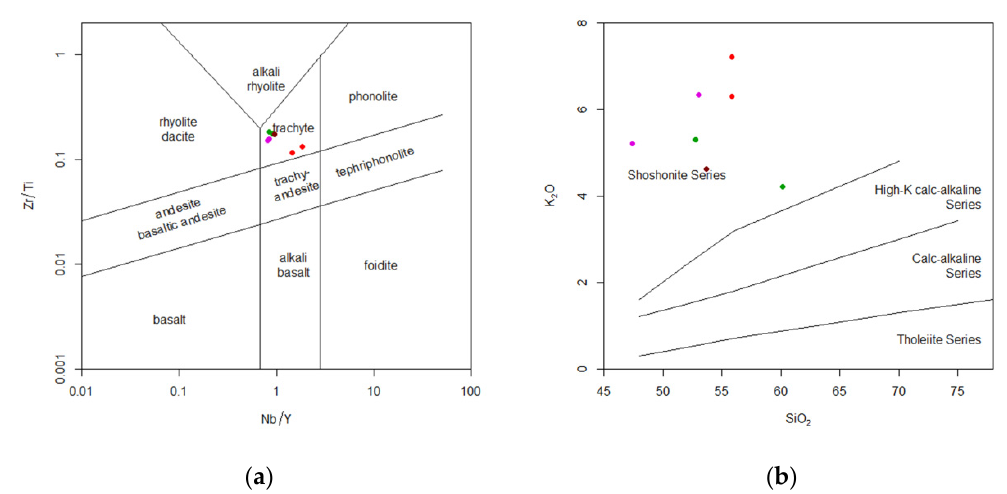
Figure 2. Plots of the Italian zeolite tuff samples ( a ) on the discrimination scheme of immobile elements Nb, Y, Zr and Ti modified by [25] and ( b ) on the classification scheme of [26]. Table 2. Chemical analysis of the zeolite tuff samples.